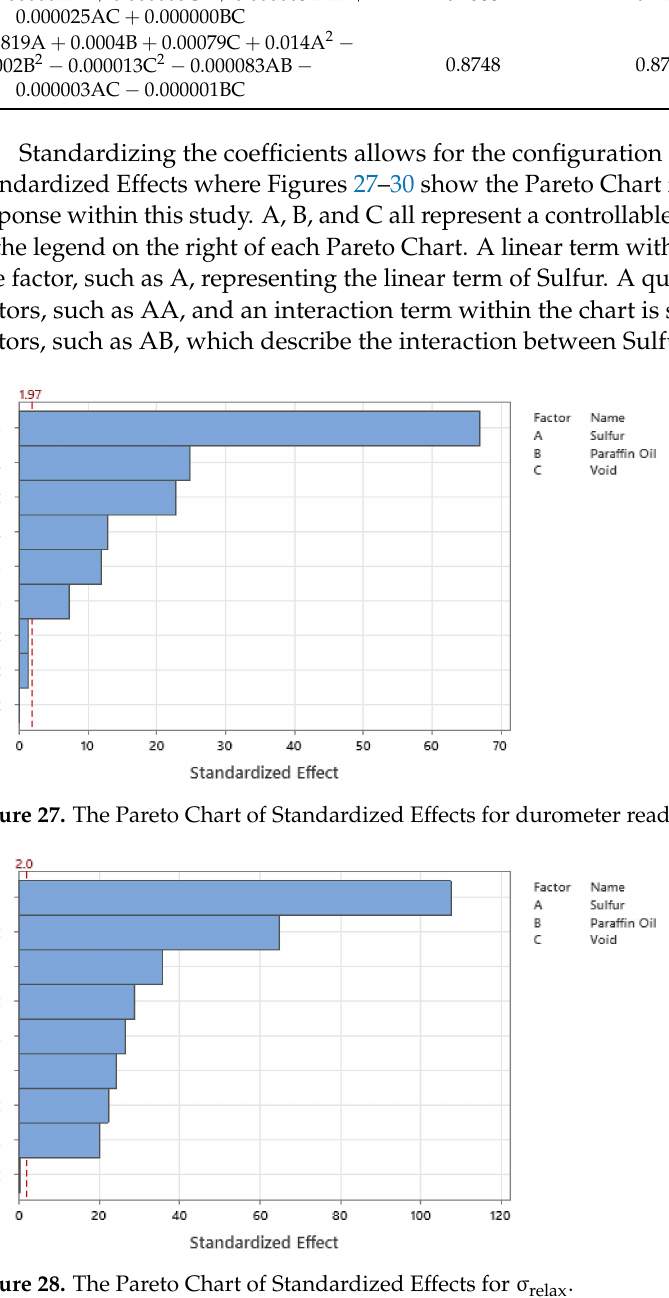
Figure 28. The Pareto Chart of Standardized Effects for σ relax